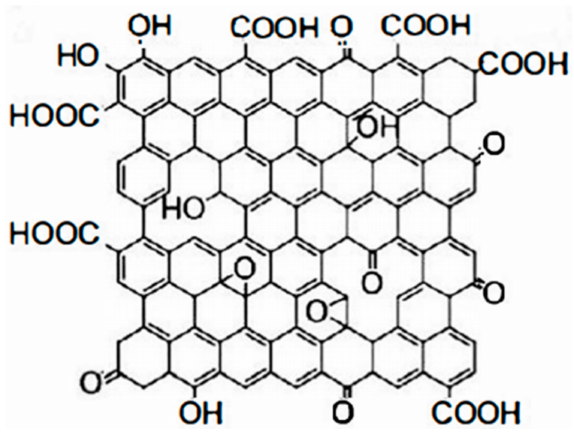
Figure 2. Molecular structure of